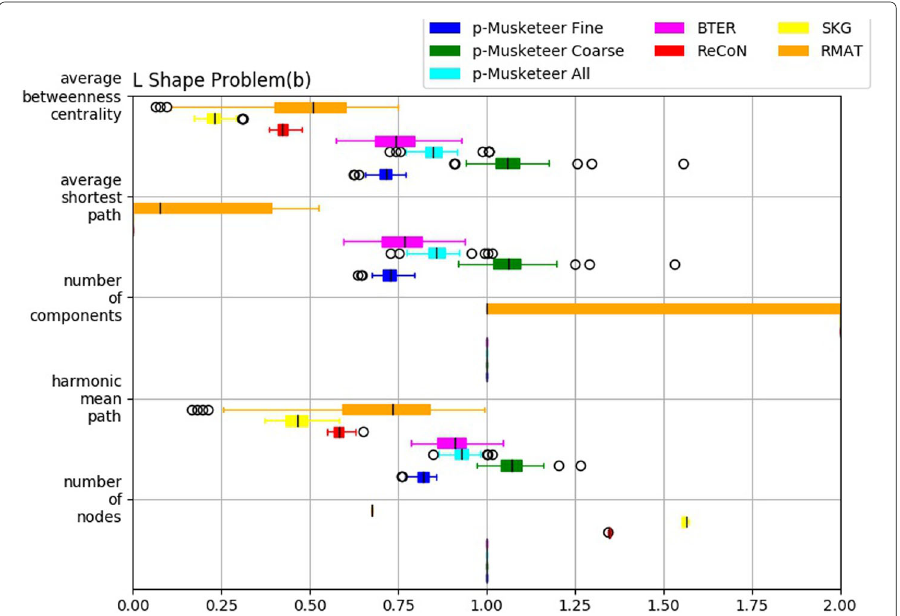
Fig. 13 Computational results on performance of planar Musketeer on graph for thermal L-Shape Problem with 3025 nodes and 8904 edges for number of nodes, harmonic mean path, number of components, average shortest path and average betweenness centrality